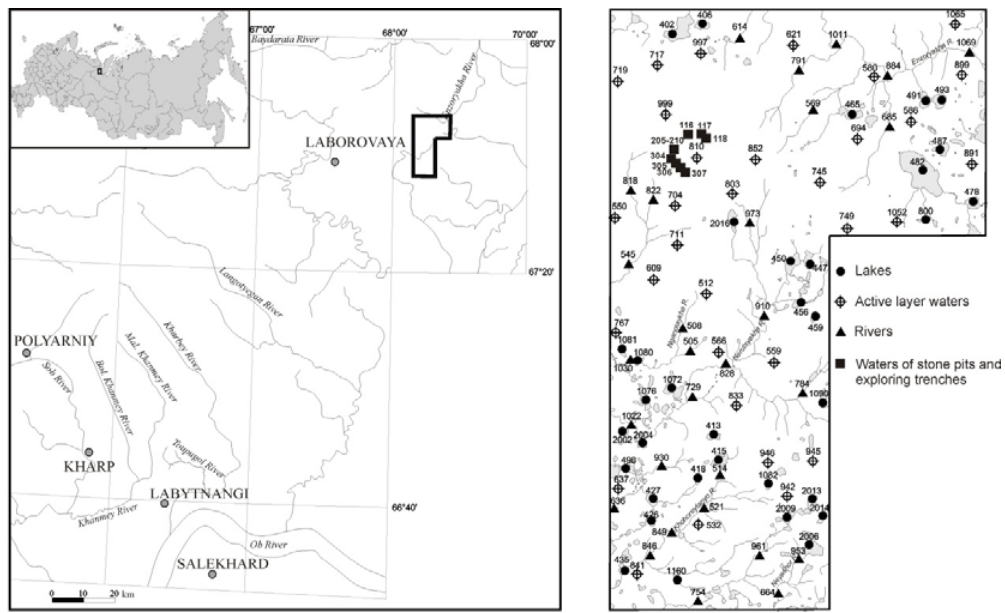
Figure 1. Sketch map of the studied area showing the sampling sites. Inset shows location of the study area in the Russian Federation.